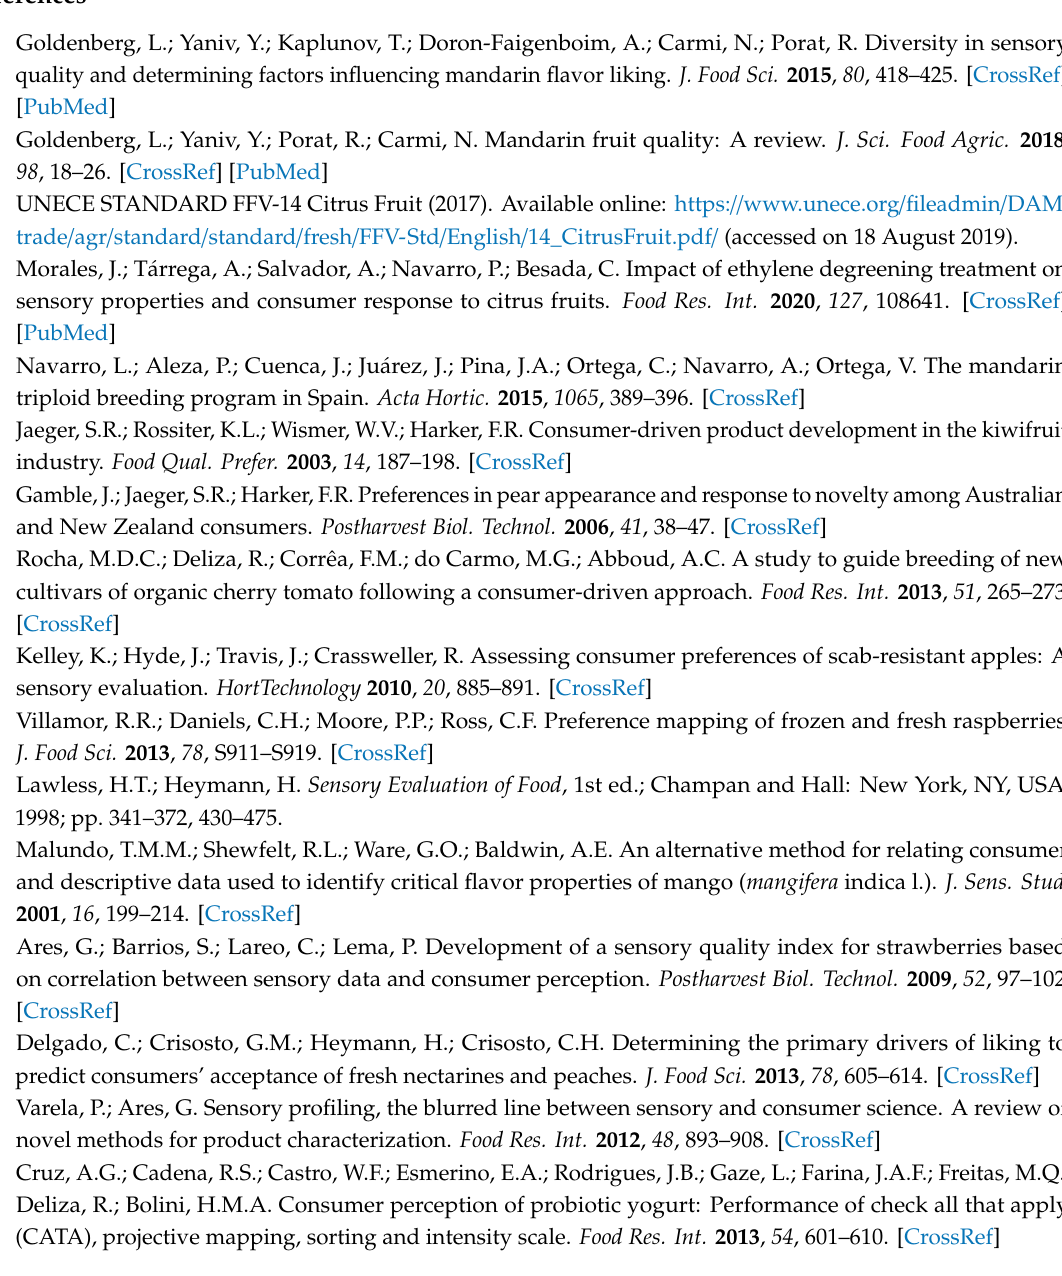
Table S1: Results of the Cochran’s Q test applied to CATA questions for Harvest 1; Table S2: Results of the Cochran’s Q test applied to CATA questions for Harvest 2. Figure S1: Dendrograms obtained from HCA applied to acceptance scores dataset from Harvests 1 (A) and 2 (B); Figure S2: Penalty analysis applied to the dataset